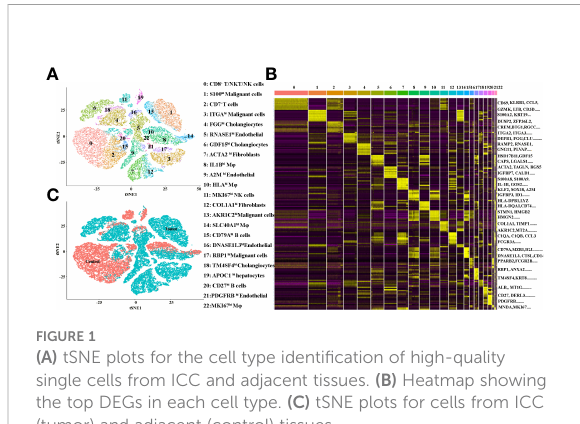
single cells from ICC and adjacent tissues. (B) Heatmap showing the top DEGs in each cell type. (C) tSNE plots for cells from ICC (tumor) and adjacent (control)